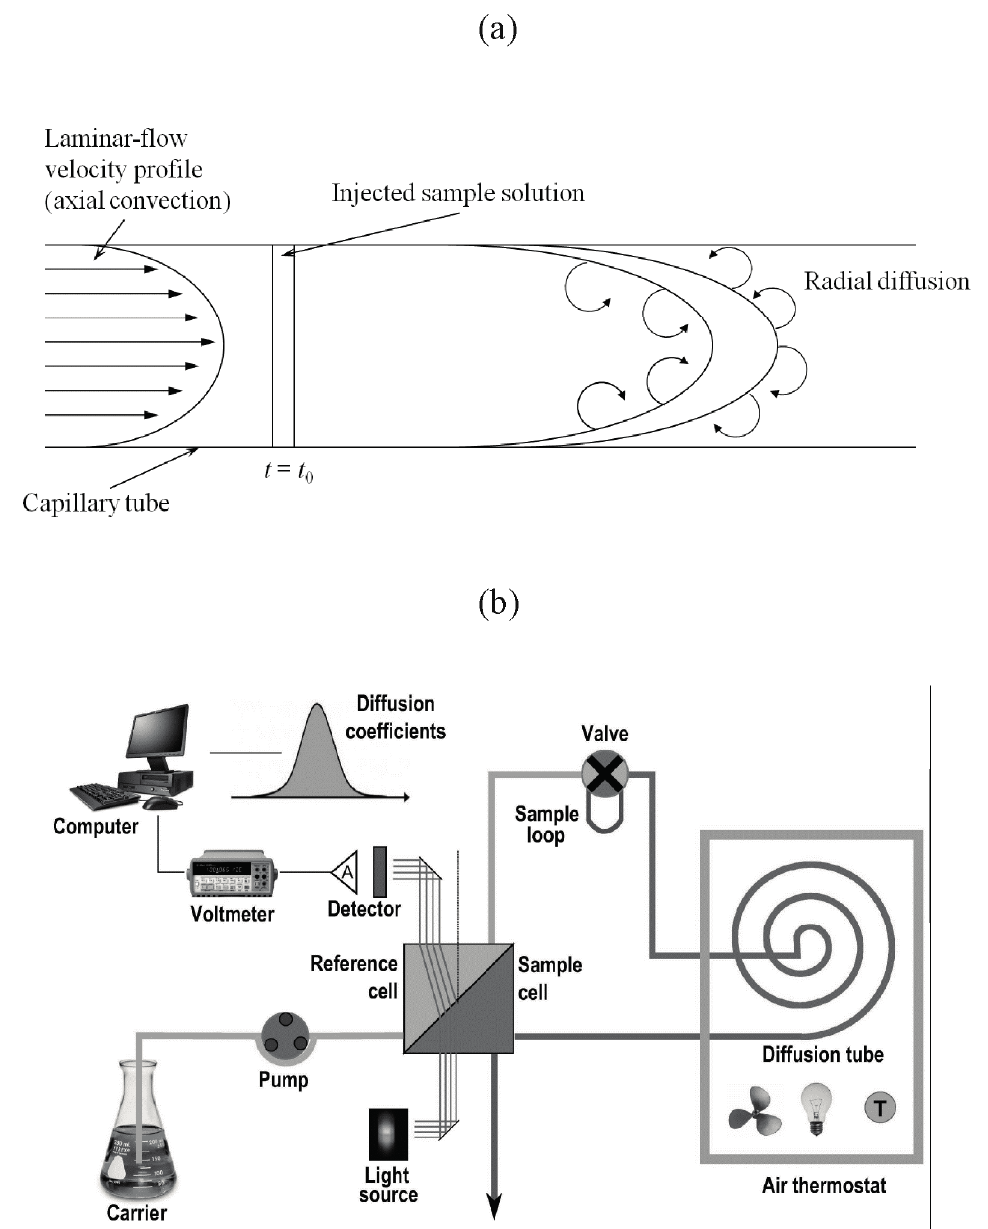
Figure 1. Schematic representation of the Taylor dispersion technique, ( a ) The principle of flow and diffusion in capillary tube; ( b ) The arrangement of the measuring